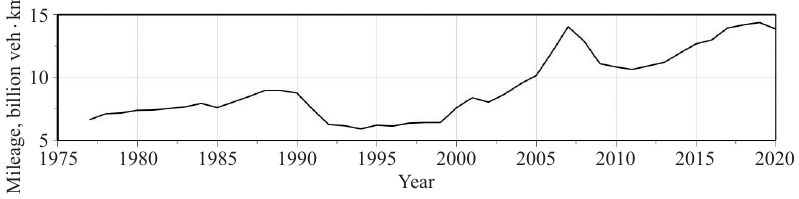
Figure 2. Vehicle total mileage growth in